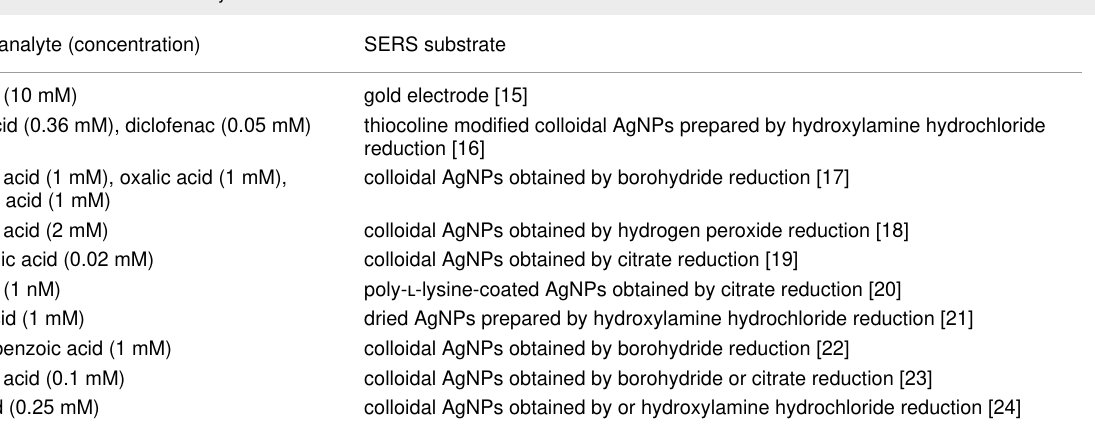
Table 1: SERS studies of anionic analytes.